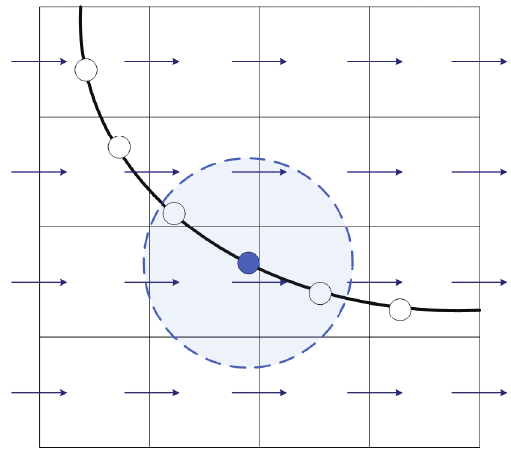
Figure 1 - Immersed geometry on a staggered finite volume computational grid. Interpolation